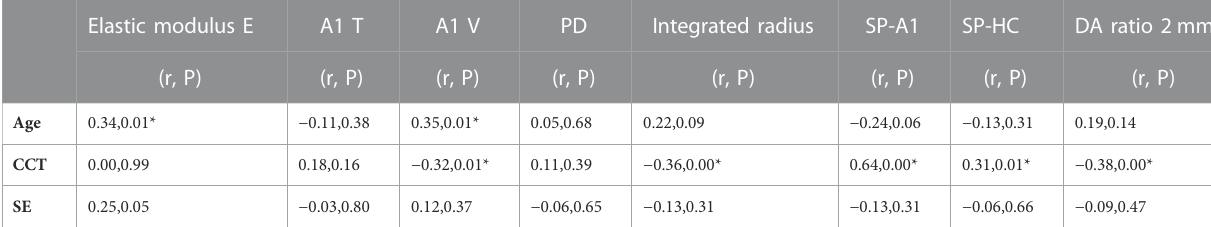
TABLE 5 Relationship between corneal mechanical indicators and age, CCT, and